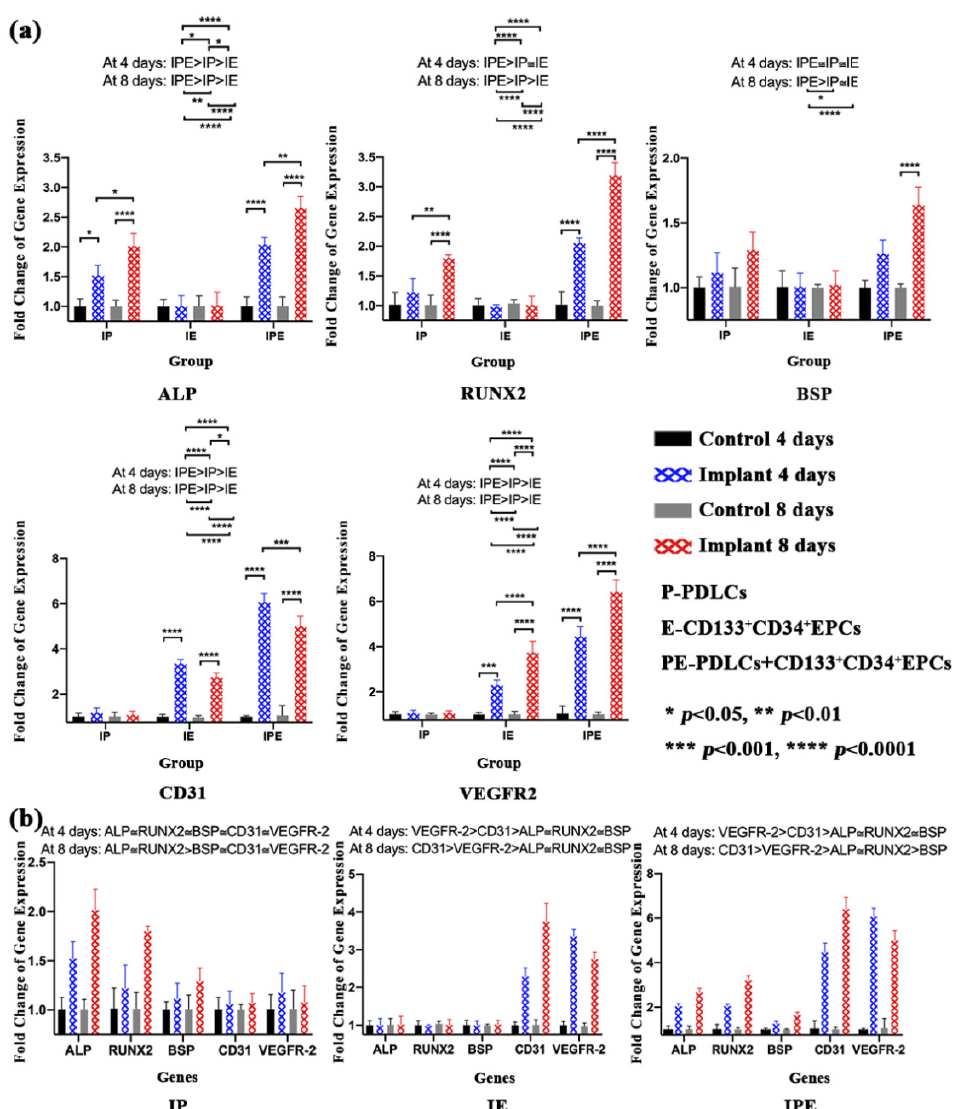
Figure 6. qRT-PCR for Cell-Disc complex in IP, IE, and IPE groups after 4 days and 8 days. ( a ) Individual gene analysis. Expression of osteogenic (ALP, RUNX-2, and BSP) and angiogenic (CD31 and VEGFR-2) genes in IP, IE, and IPE groups at day 4 and day 8. ( b ) Comparative gene analysis. Expression and comparison of osteogenic and angiogenic genes in the IP, IE, or IPE groups at day 4 and day 8.